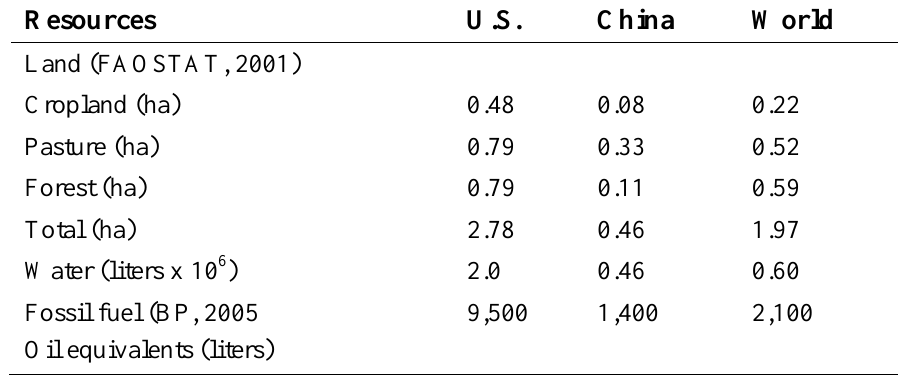
Table 2. Resources used and/or available per capita per year in the U.S., China, and the world to supply basic human needs